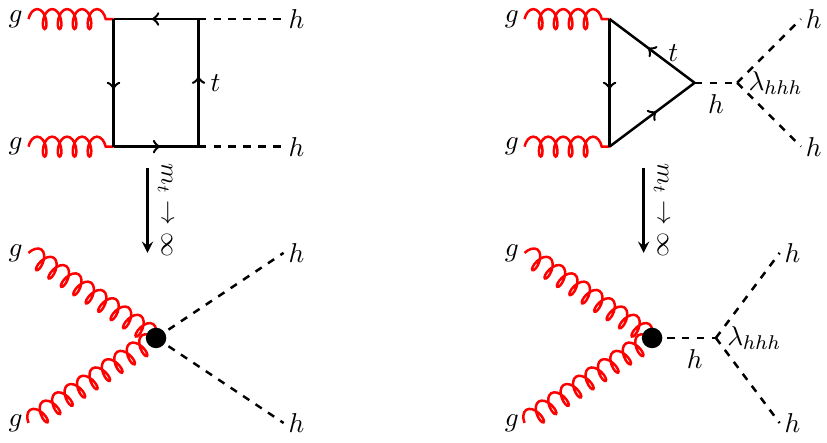
Figure 1 . Representative lowest order Feynman diagrams of gg → hh in the SM with full top quark mass dependence (upper) and in the heavy/infinite top quark mass approximation